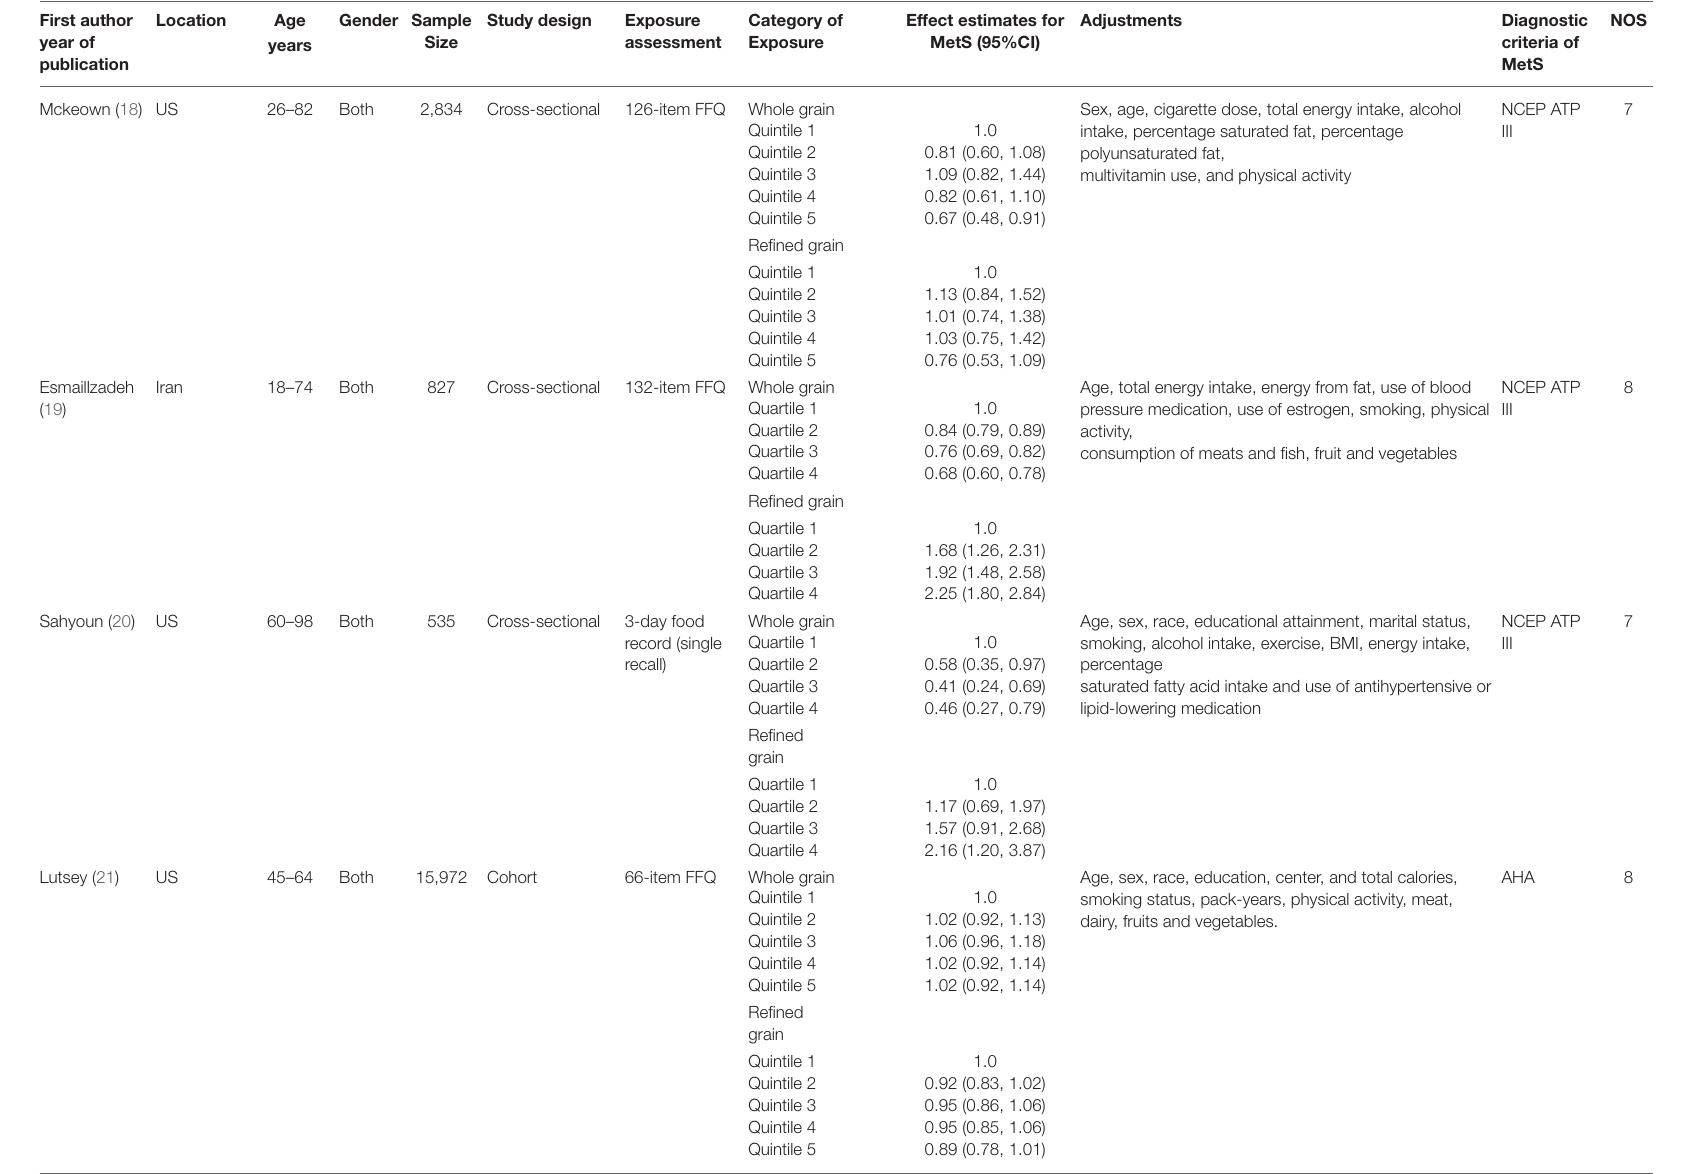
TABLE 1 | Characteristics of the individual studies included in this